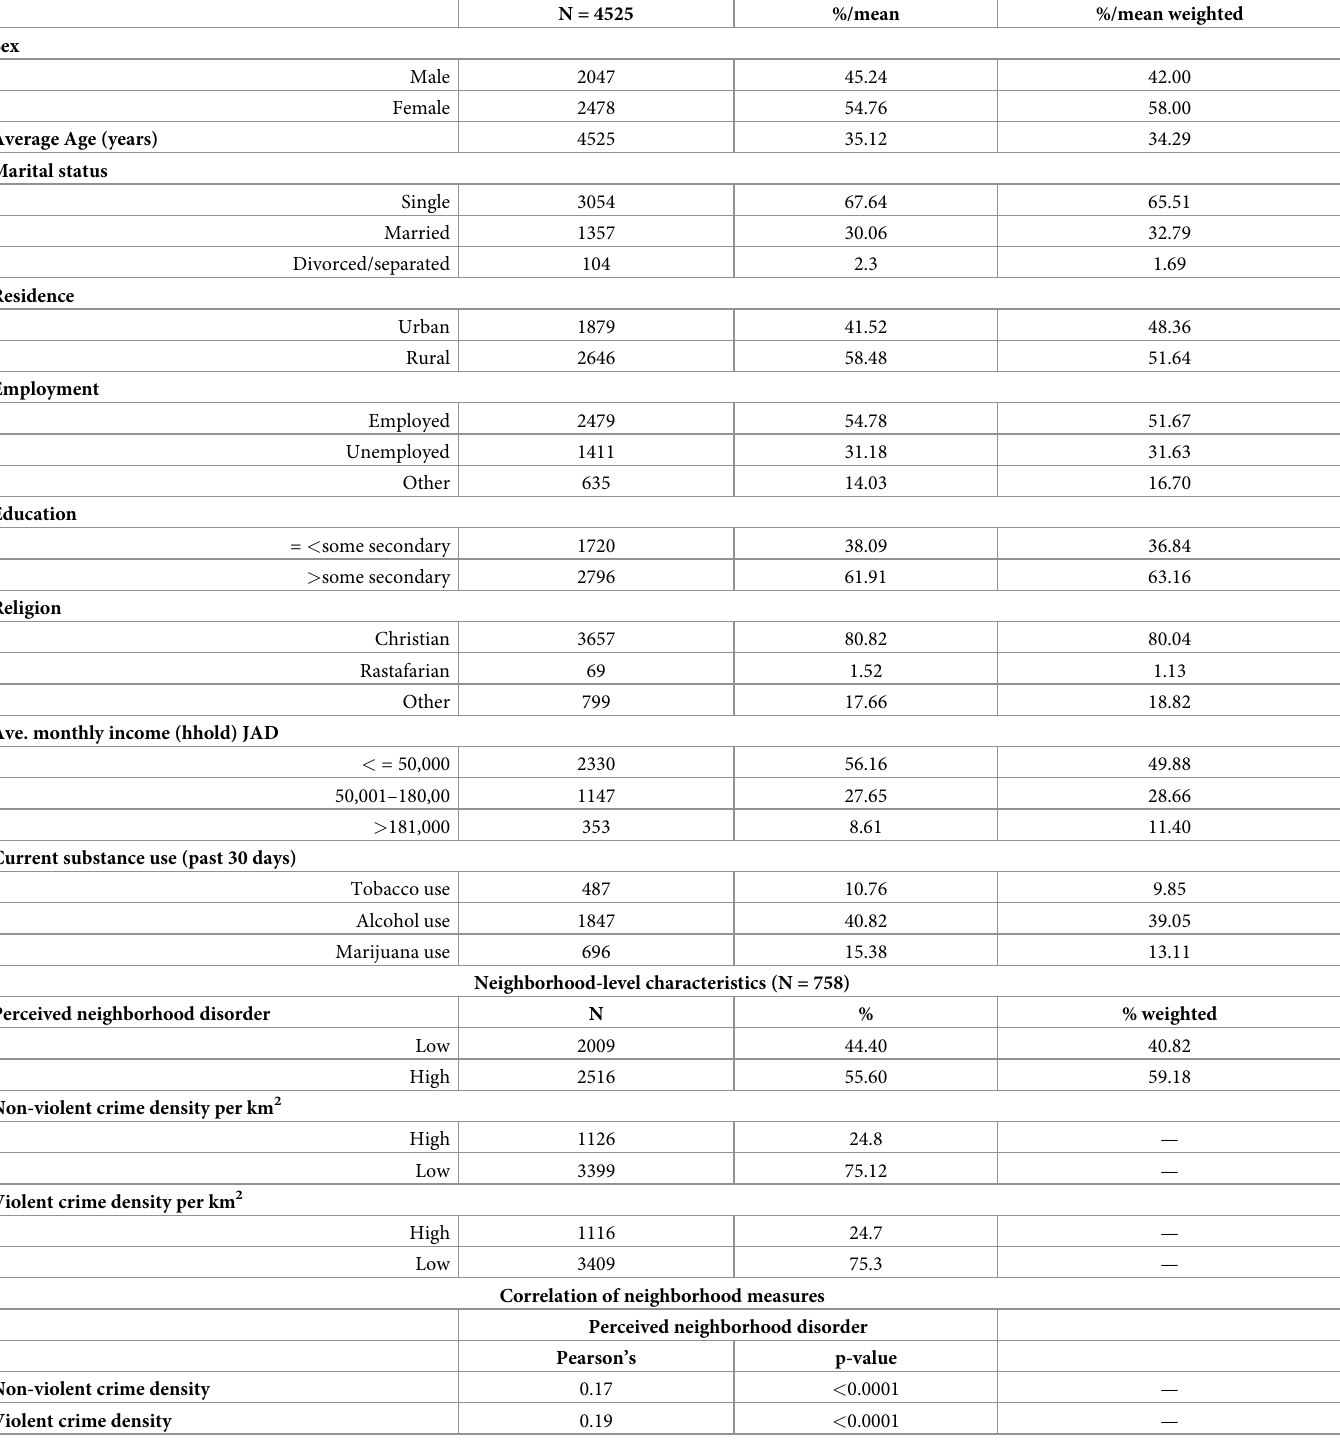
Table 1. Un-weighted and weighted characteristics of study population in Jamaica’s National Drug Survey, 2016 (N =